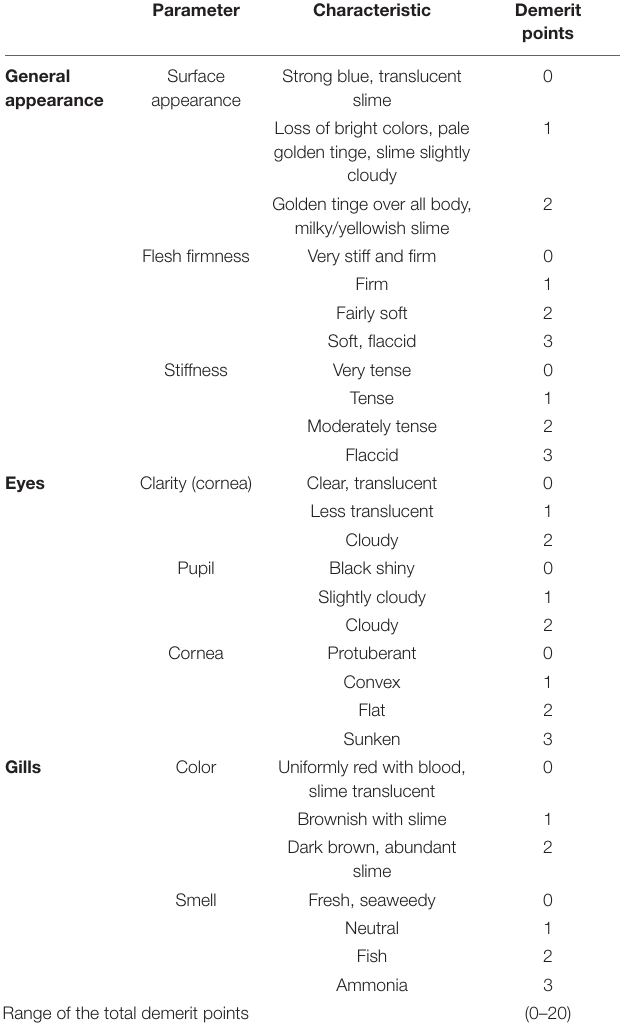
TABLE 1 | Quality Index Method (QIM) scheme for sensory